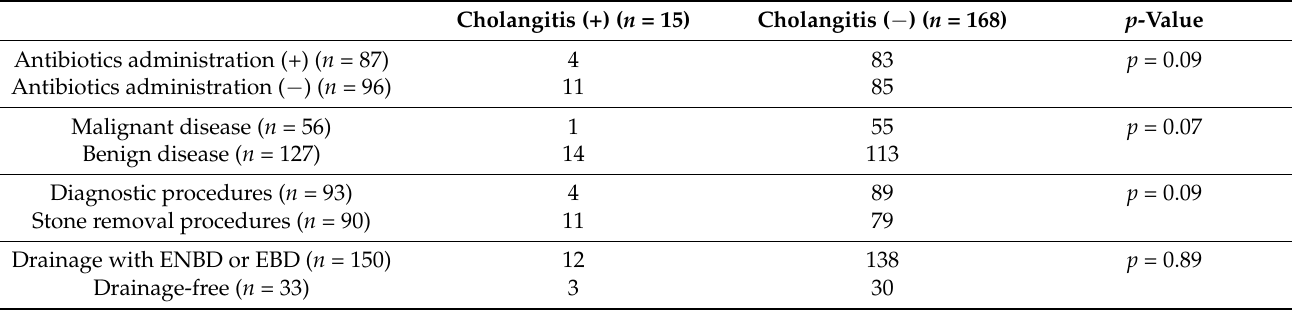
Table 6. Analysis of risk factors for cholangitis.